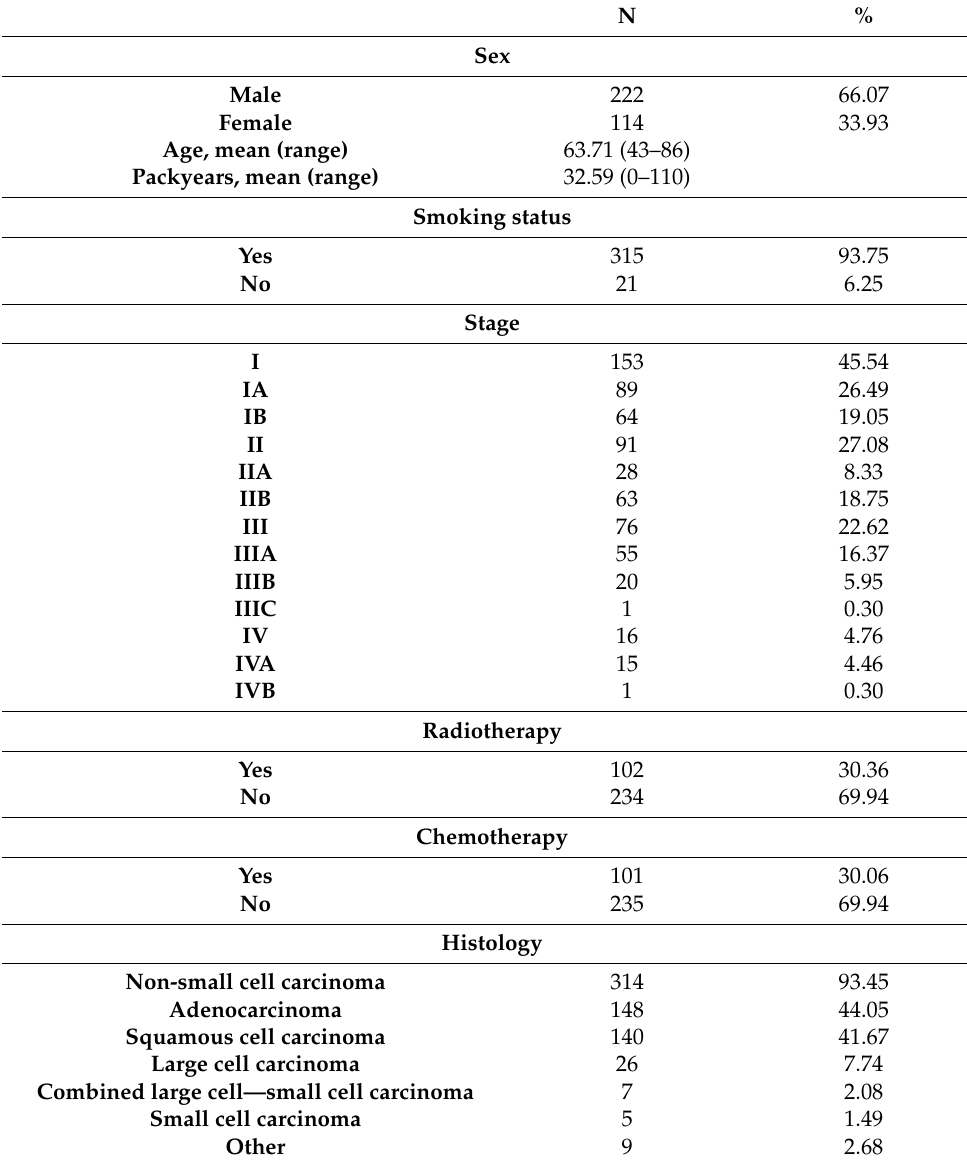
Table 1. Characteristics of the study group ( n =